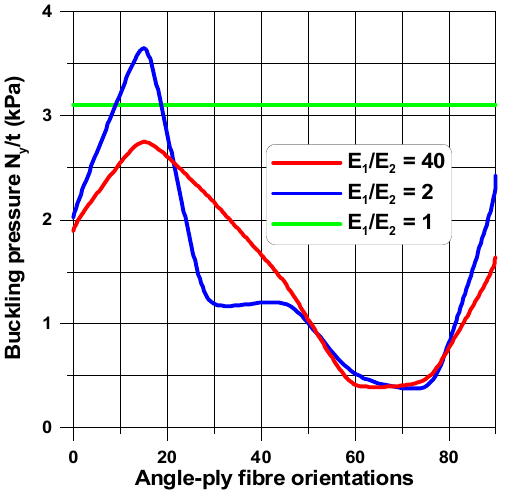
Figure 8. Distributions of buckling loads with fibre orientations ( θ ) and the orthotropic parameter, β = E 1 / E 2 , G 12 / E 1 = 0.015 . The rectangular plate ( L x / L y = 1.25) for the elliptical horizontal hole, 2 b / L x = 0.16.